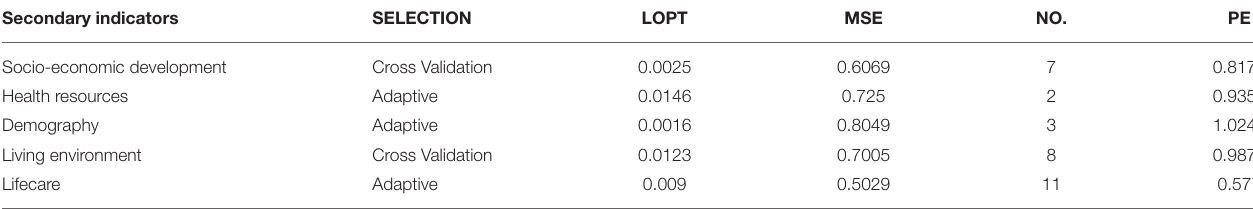
TABLE 2 | Variable results filtered by Lasso